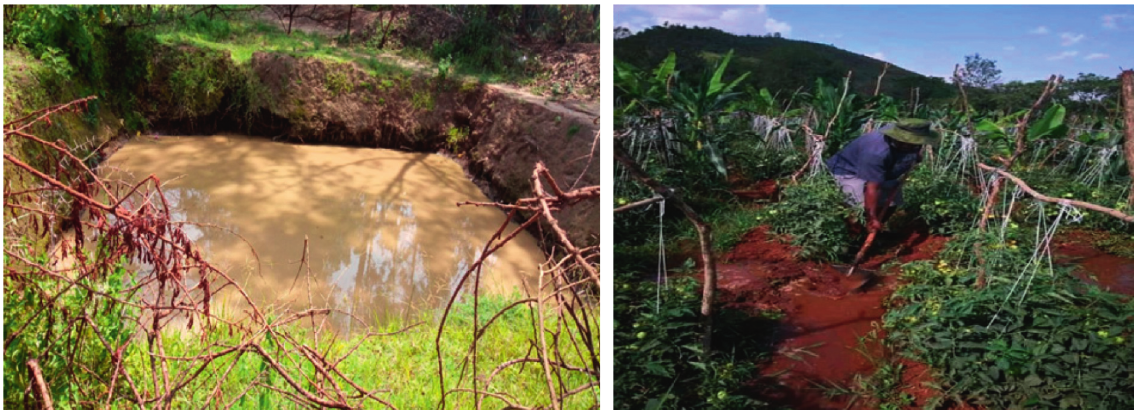
Figure 3: Water availability and irrigation work in Damot area districts.